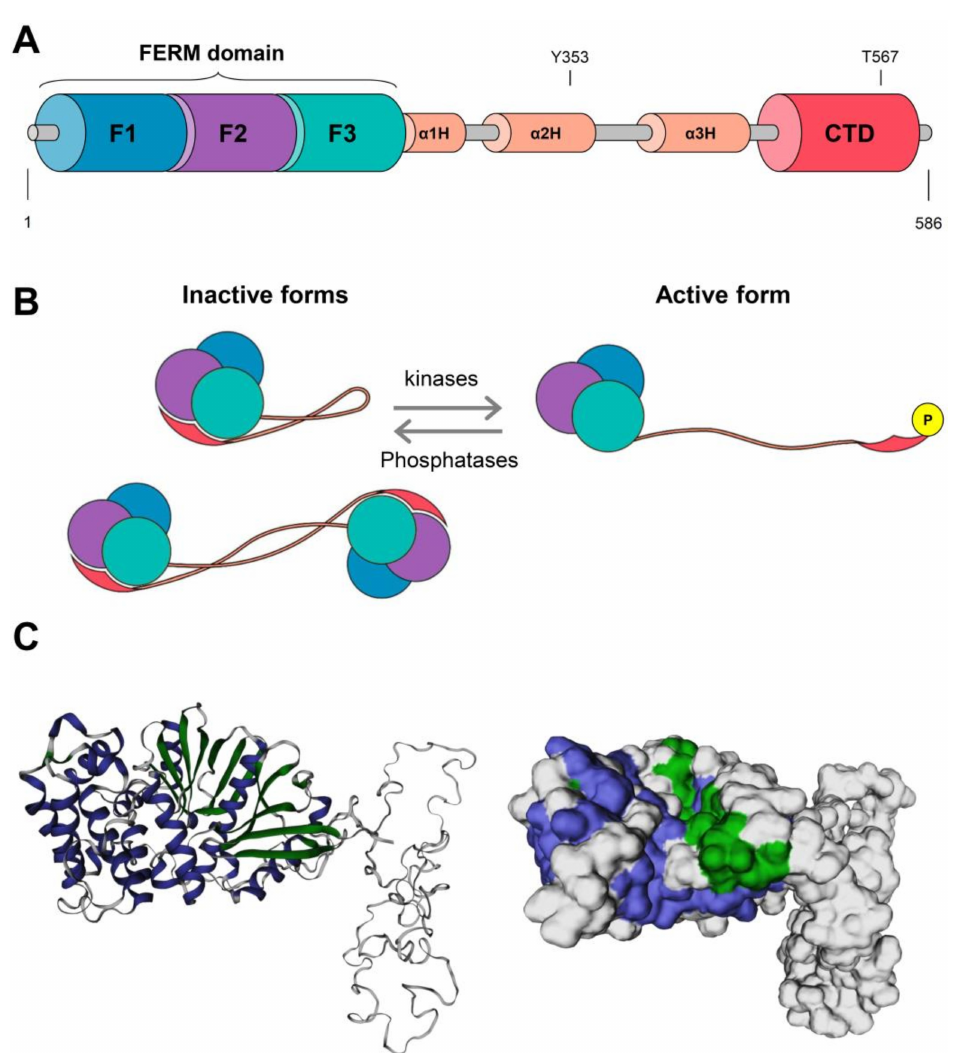
Figure 2. Protein structure and activation model for ezrin (EZR). ( A ) The N-terminus consists of a domain called FERM (band 4.1 protein, ezrin, radixin, moesin) formed by three subunits F1, F2, and F3, after which there is a helical domain called α 1H, α 3H, and α 3H followed by a C-terminal domain (CTD) subunit, where the ezrin phosphorylation sites (Y353 and T567) are found. ( B ) Representation of active and inactive forms of EZR. It can interact intermolecularly with itself when inactive, forming a monomer or even a dimer with another protein. When it experiences the action of kinases and is phosphorylated, ezrin is activated, “extends”, and passes to a new conformation. The action of phosphatases reverses this conformation. This illustration was adapted from Michie et al. [11]. The three subunits F1 (blue lobe), F2 (purple lobe), and F3 (green lobe) for the FERM domain, helical domain (orange line), and C-terminal domain (pink) are illustrated. ( C ) The 3D reconstitution of the EZR protein was constructed using the SWISS-MODEL platform (https://swissmodel.expasy.org/, accessed on 2 August 2021), and cartoon and surface versions of the protein are illustrated. Alpha- helix structures are shown in purple, beta-pleated sheet structures are in green, and other structures are in